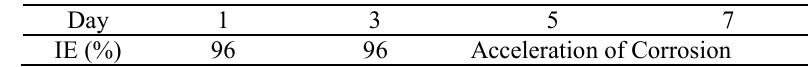
Table 3. Influence of immersion period on the IE, Cl - = 120 ppm SM = 50 ppm, Zn 2+ = 50 ppm pH = 7.